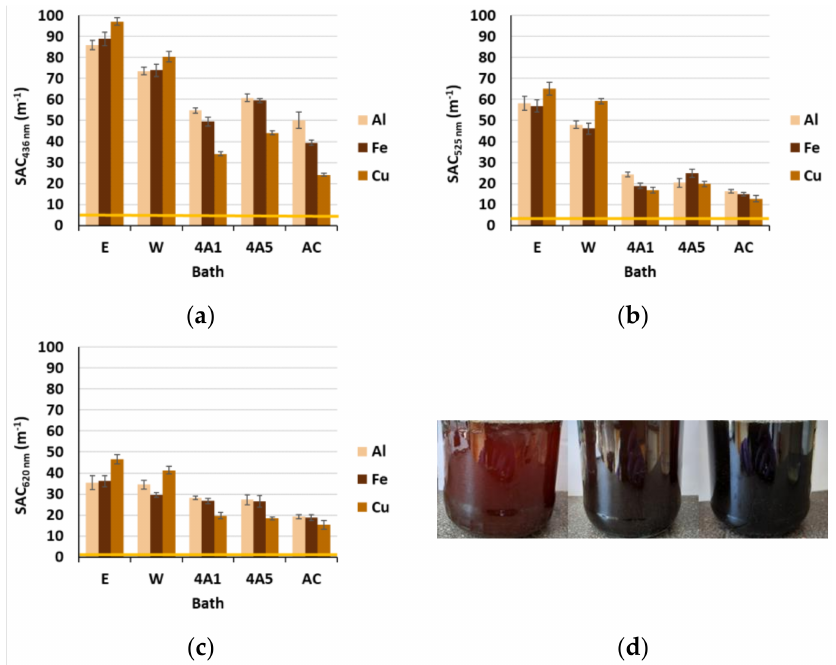
Figure 5. SAC values at: ( a ) 436 nm; ( b ) 525 nm; ( c ) 620 nm; and ( d ) corresponding photograph of effluents after dyeing. The yellow lines are the limit values for discharge of wastewater into watercourses from installations for the production, processing and treatment of textile fibers (UL RS 7/2007 and Council Directive 2006/11/ES).